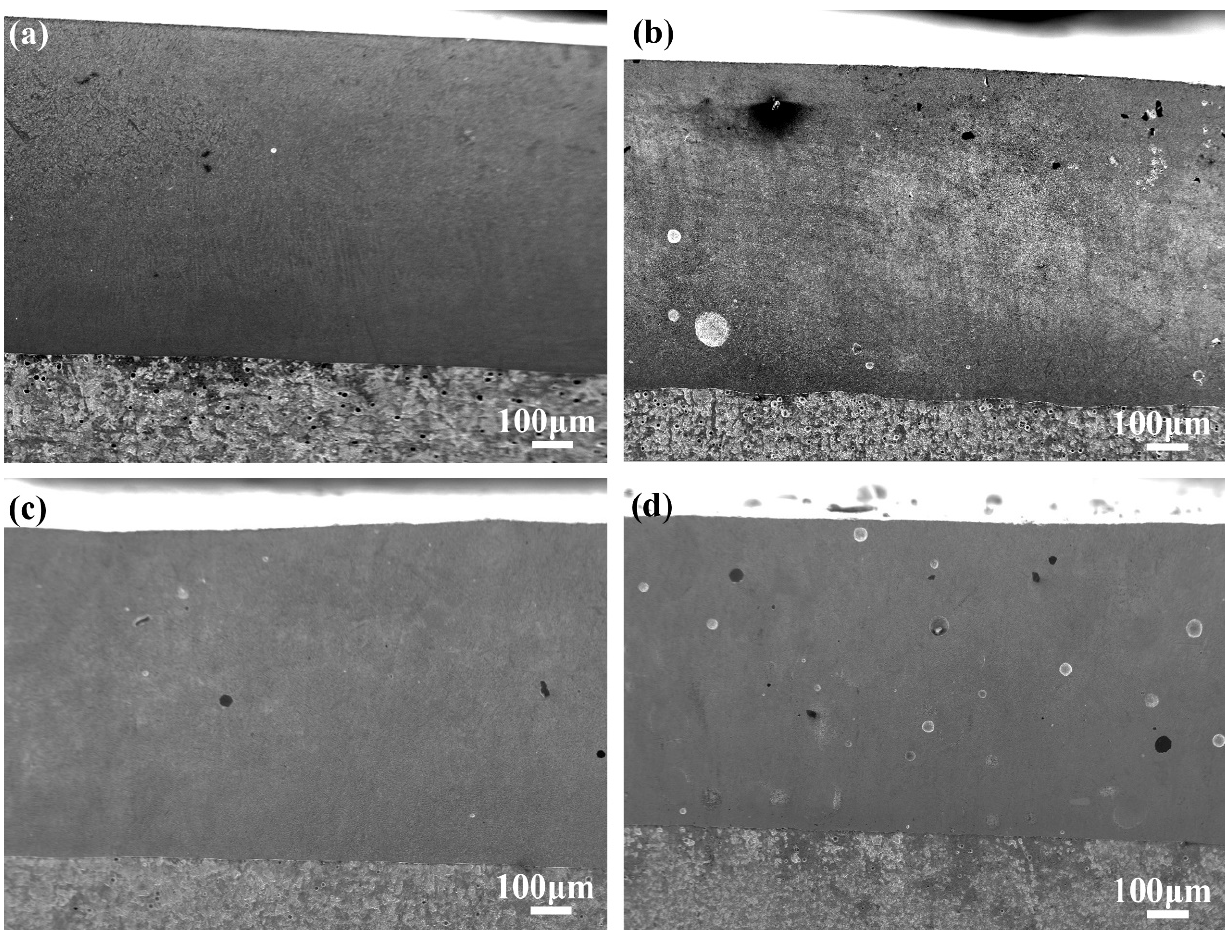
Figure 4. SEM images of overall cross-sectional nickel-based composite coatings with different NiGNPs content: ( a ) 0, ( b ) 10%, ( c ) 20% and ( d )